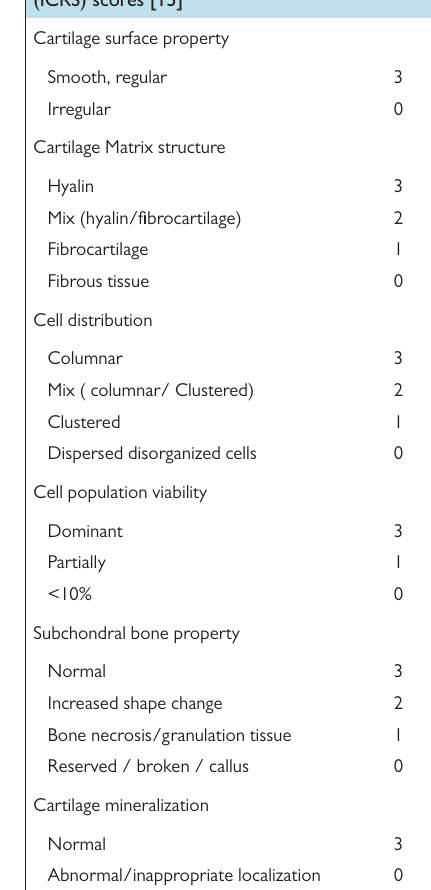
Figure 2. a-d. Macroscopic view of the a) biomimetic scaffold; b) chondral scaffold; c) micro fracture group (arrows show 4 microcircular holes in the microfracture); and d) control group. Table 3. International Cartilage Repair